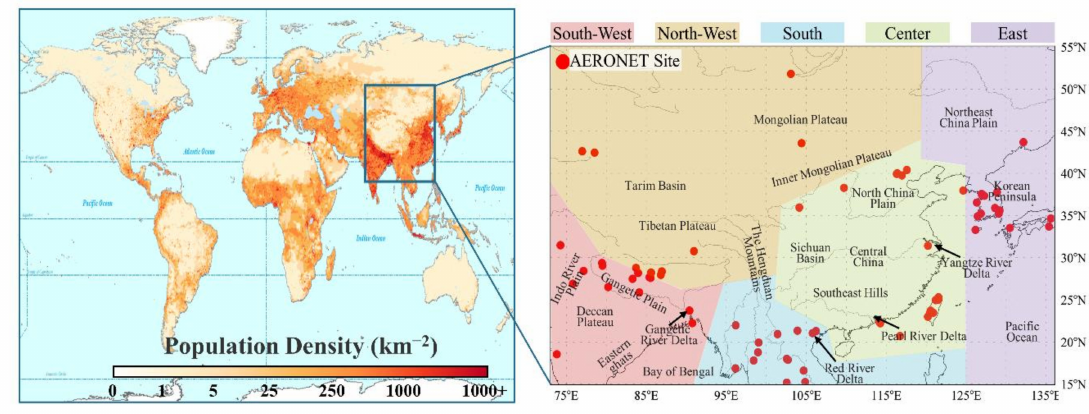
Figure 1. Geographical distribution of the world population density and the location of the study region (73 ◦ –136 ◦ E, 15 ◦ –55 ◦ N). Red dots represent the geographical distribution of AERONET sites used in the